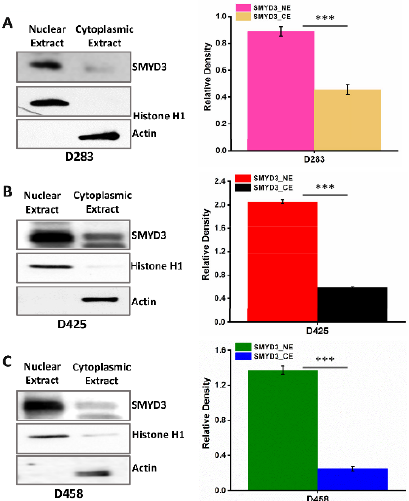
Figure 3. Group 3 MB cells express higher SMYD3 levels in the nucleus ( A – C ) Immunoblot of nu- clear extracts (NE) and cytoplasmic extracts (CE) from D283, D425, and D458 MB cells, respectively using the anti-SMYD3 antibody. Densitometry analysis for the SMYD3 expression in the cellular fractions of Group 3 MB cell lines. The statistical significance *** p < 0.001